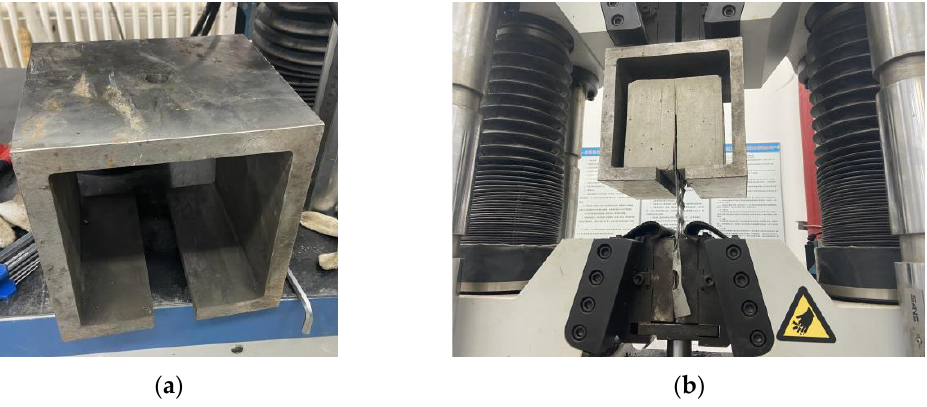
Figure 1. Pull-out test of perforated steel plate reinforced concrete: ( a ) drawing fixture; ( b ) pull-out test.